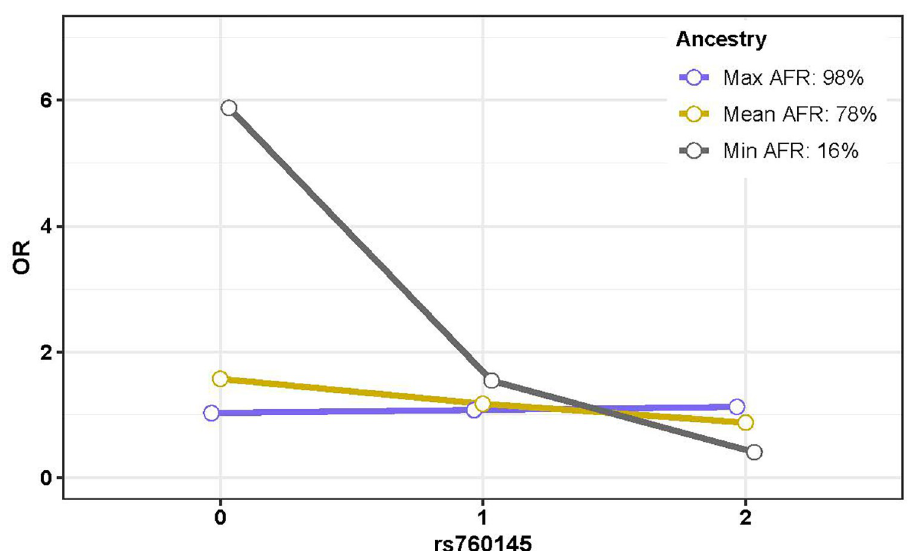
Fig 5. Global ancestry risk modification in African Americans. Expected odds ratios (OR) are depicted on the Y axis for individuals with 0, 1, or 2 copies of the variant allele for each SNP, under varying levels of AFR ancestry. A protective effect is seen in individuals with the minimum observed AFR while no effect is seen for individuals with the maximum or mean observed AFR.